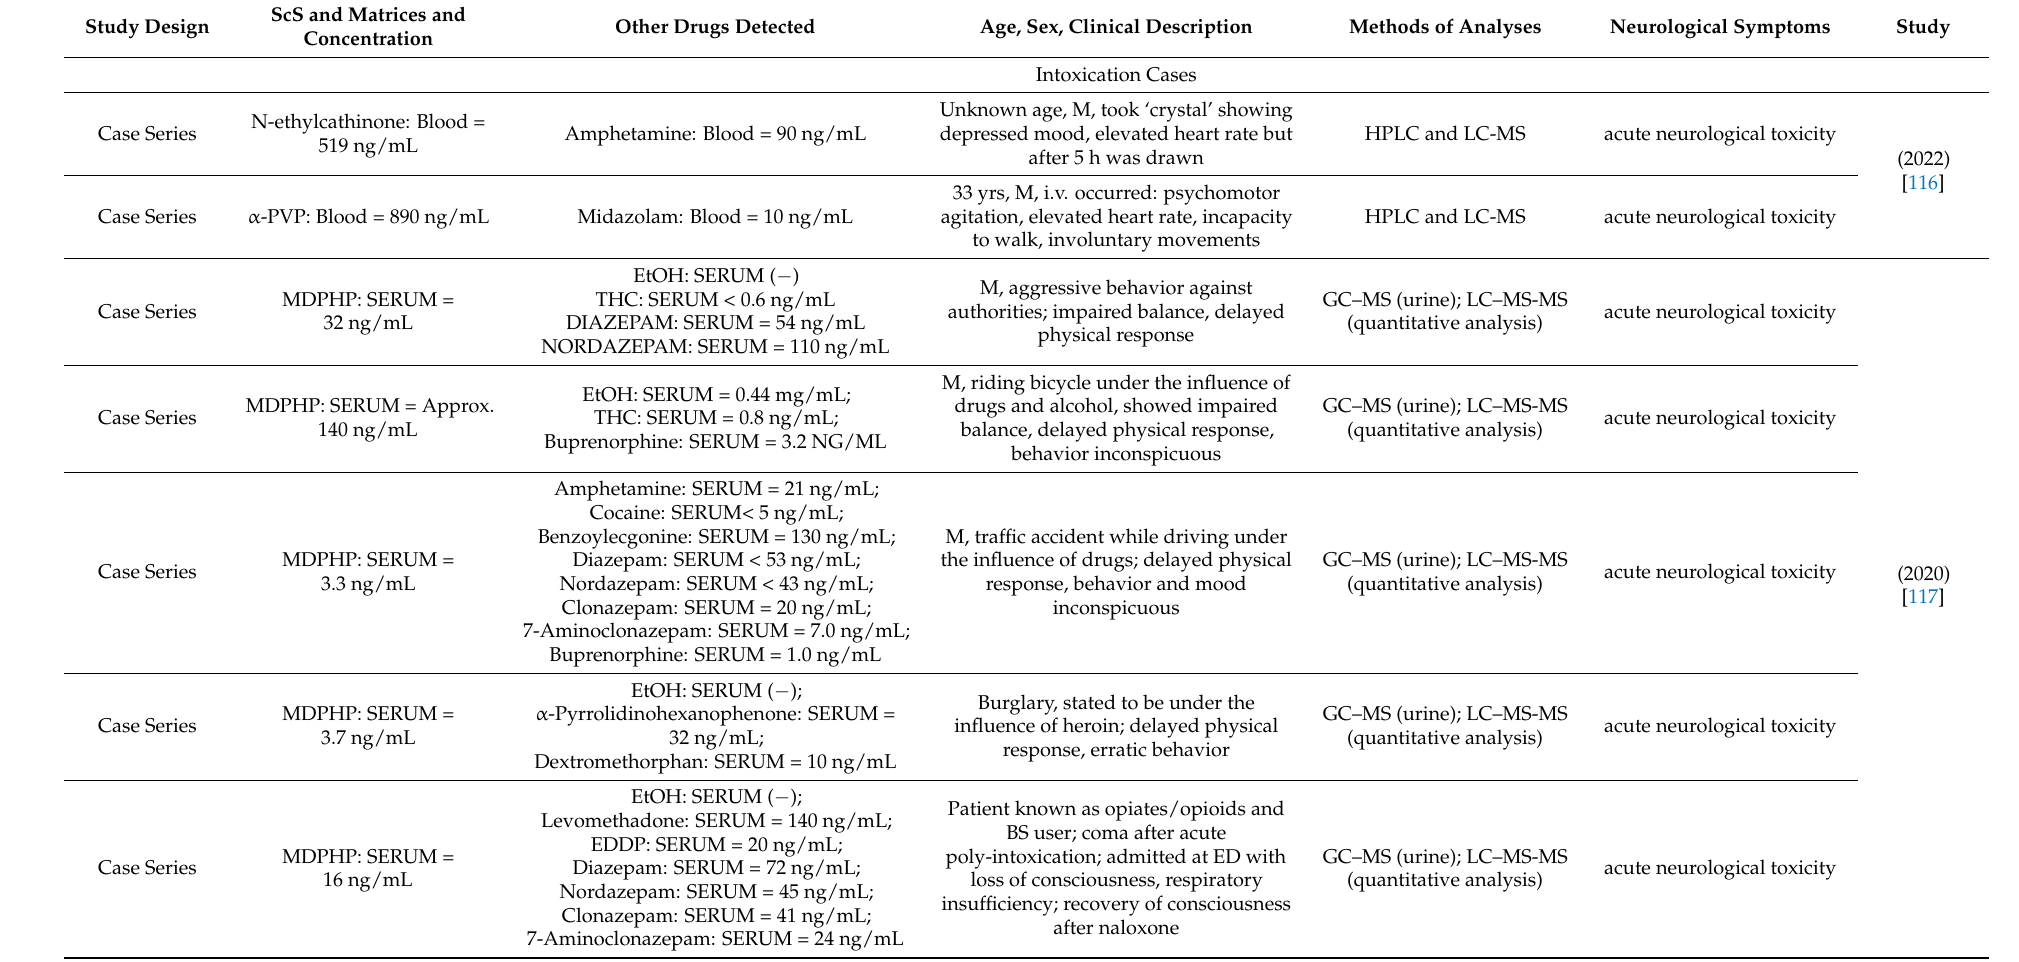
Table 3. Characteristics of eligible studies—neurological intoxication by SCs and fatalities in human